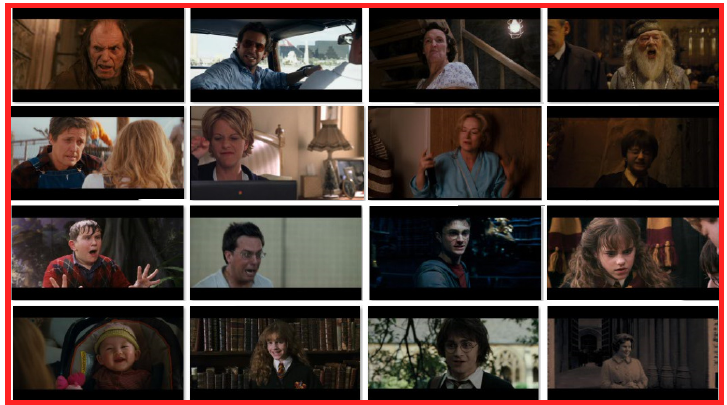
Figure 10. Some image samples from the SFEW